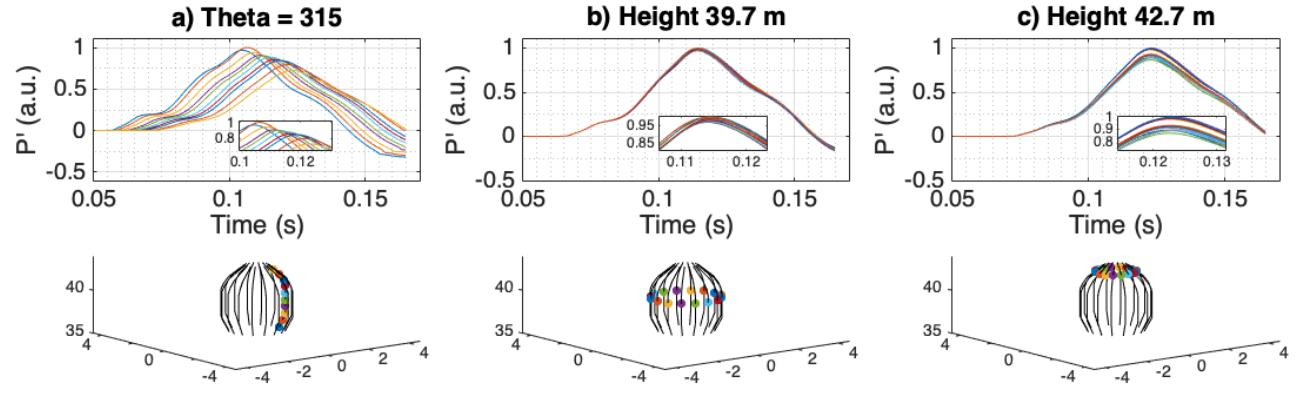
Figure 6. Pressure temporal evolution along the fairing at ( a ) an azimuth angle of 315º and different heights, ( b ) at a constant height of 39.7 m with different azimuth angles, and ( c ) at 42.7 m and different azimuth angles.